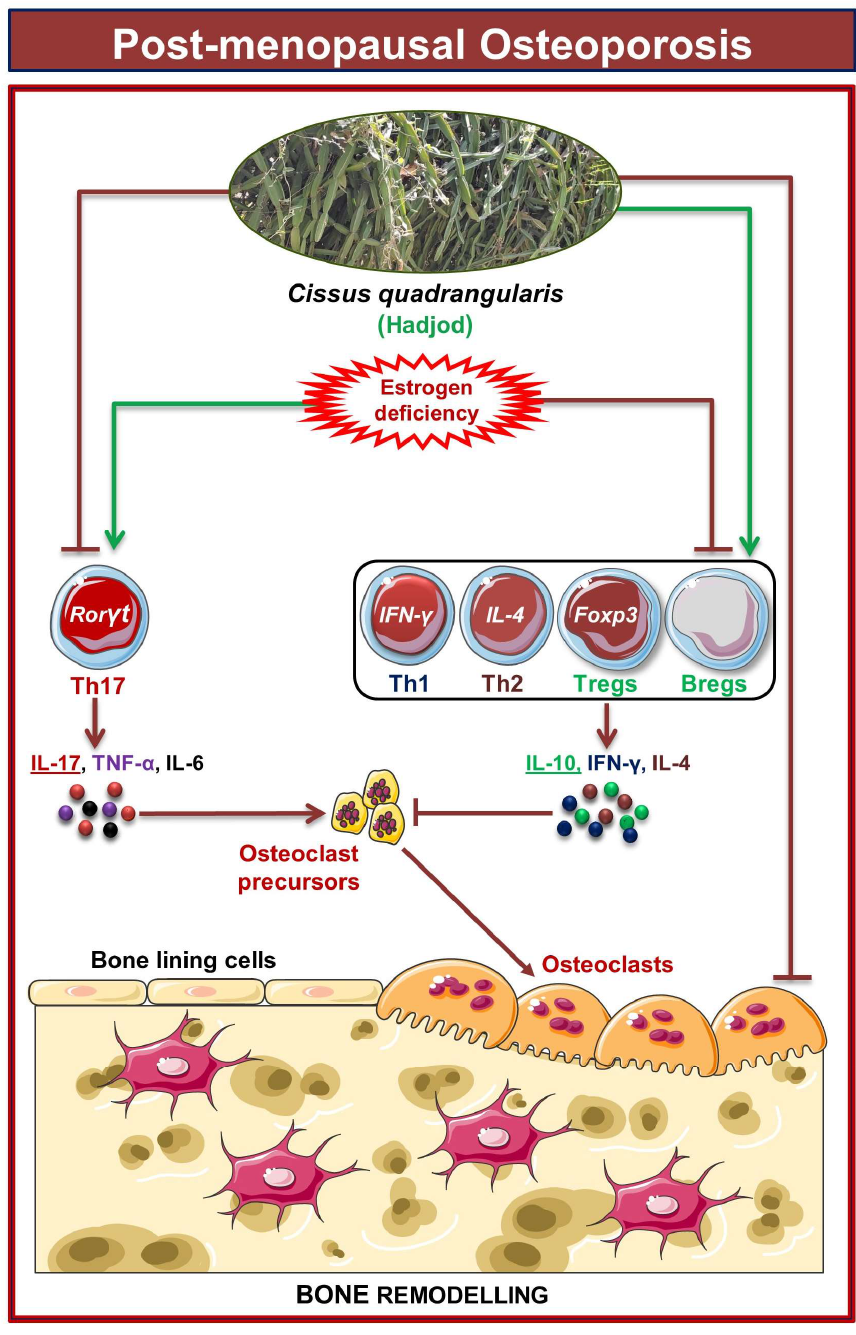
Figure 11. Results summary: In PMO conditions, oral administration of CQ improves bone health by reducing the percentage of Th17 cells along with simultaneously increasing the percentages of Th1, Th2, Tregs, and Bregs immune cells in various lymphoid organs of the Ovx mice. The image was produced using Servier Medical Art, a resource made available by Servier and distributed under a Creative Commons Attribution 3.0 Unported license ( https://smart.servier.com ).